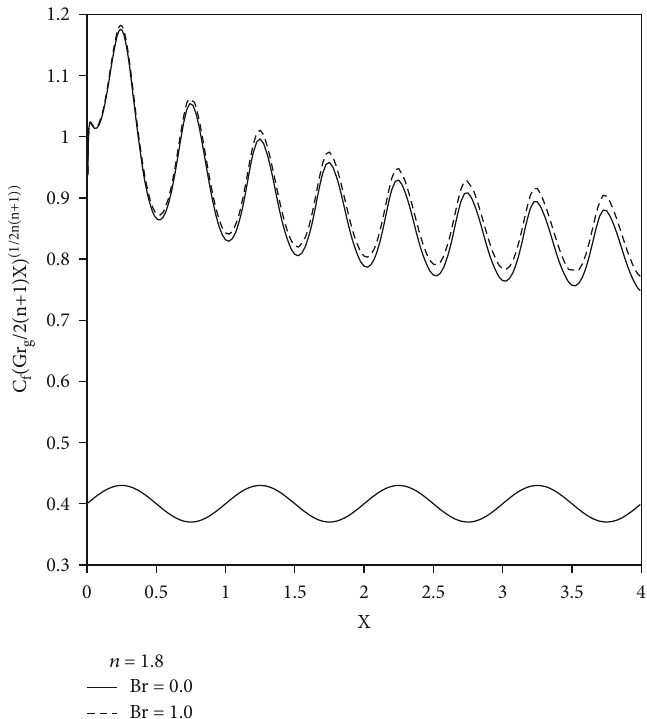
Figure 5: The axial distribution of the skin friction coe ffi cient for Pr